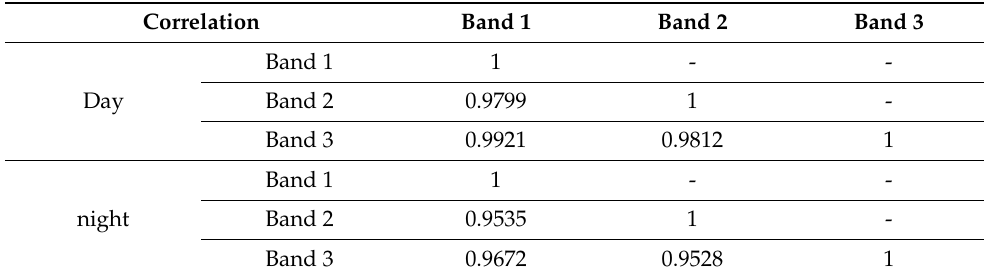
Table 4. The summary of correlation